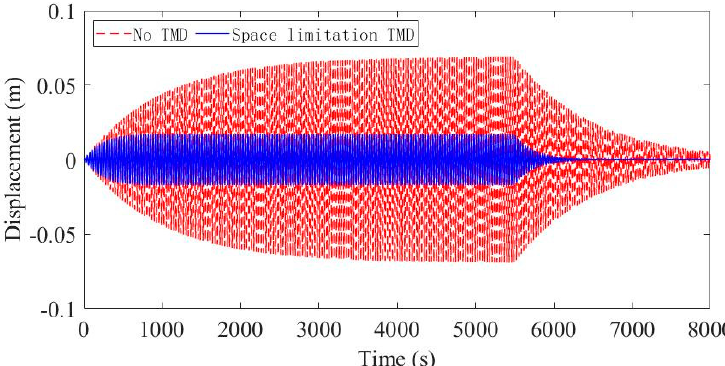
Figure 17. Comparison of free decay of floating wind turbine with stroke-limited TMD and without TMD.